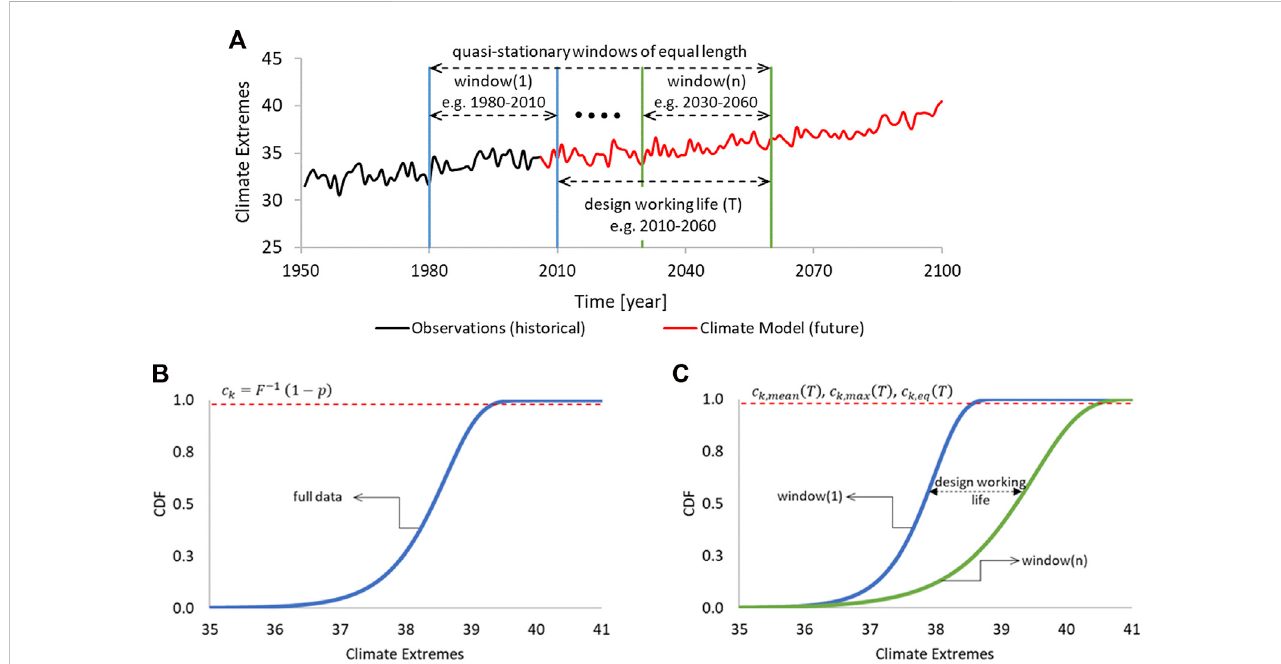
FIGURE 2 Concept of the stationary and non-stationary characteristic values: (A) de fi nition of quasi-stationary windows for extreme value analysis; (B) stationary assumption, one distribution function; (C) non-stationary assumption, “ n ” distribution functions.